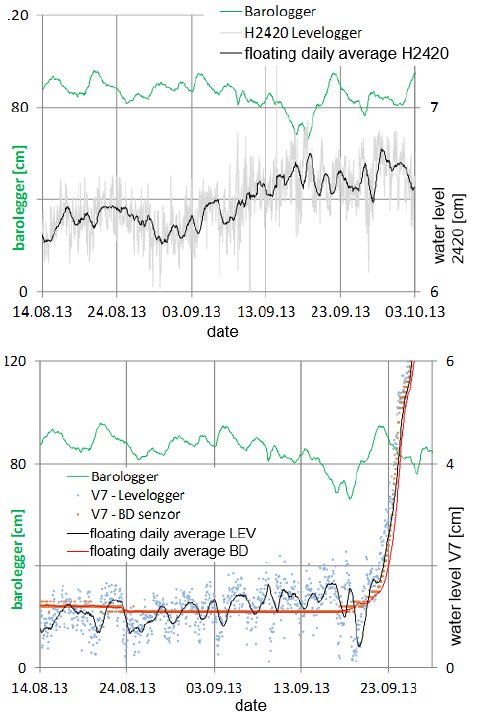
Fig. 10. Up: parallel courses of the atmospheric pressure and the automatically compensated water level in H248. The "overcom- pensation" is distinctive. Bottom: the same period recorded for V7 in comparison with relative pressure probe record (red